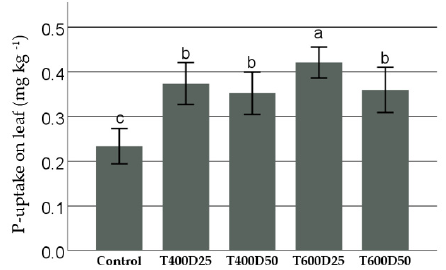
Figure 5. P absorption on the leaf in the five experimental treatments: dosage 0 t ha − 1 (control), dosage 25 t ha − 1 at 600 ◦ C (D25T400), a dosage of 50 t ha − 1 at a temperature of 400 ◦ C (D50T400), dosage 25 t ha − 1 at 600 ◦ C (D25T600), and a dosage of 50 t ha − 1 at a temperature of 600 ◦ C (D50T600) after six months planted in the field. Different letters above the bars indicate statistically significant differences between the sampling times within the same treatment ( p ≤ 0.05). Vertical bars represent the standard error of the